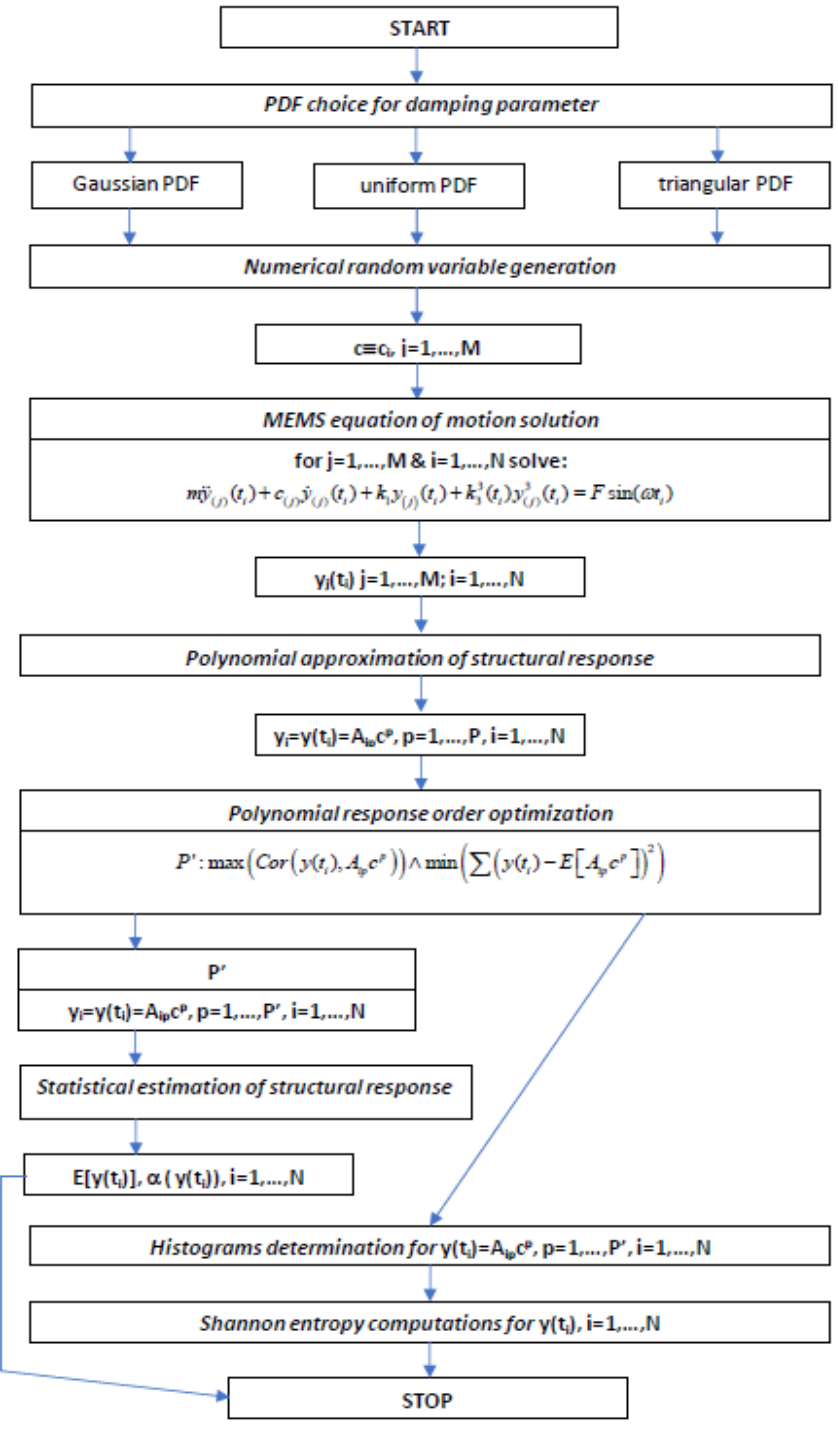
Figure 2. Flowchart of probabilistic entropy numerical simulation.